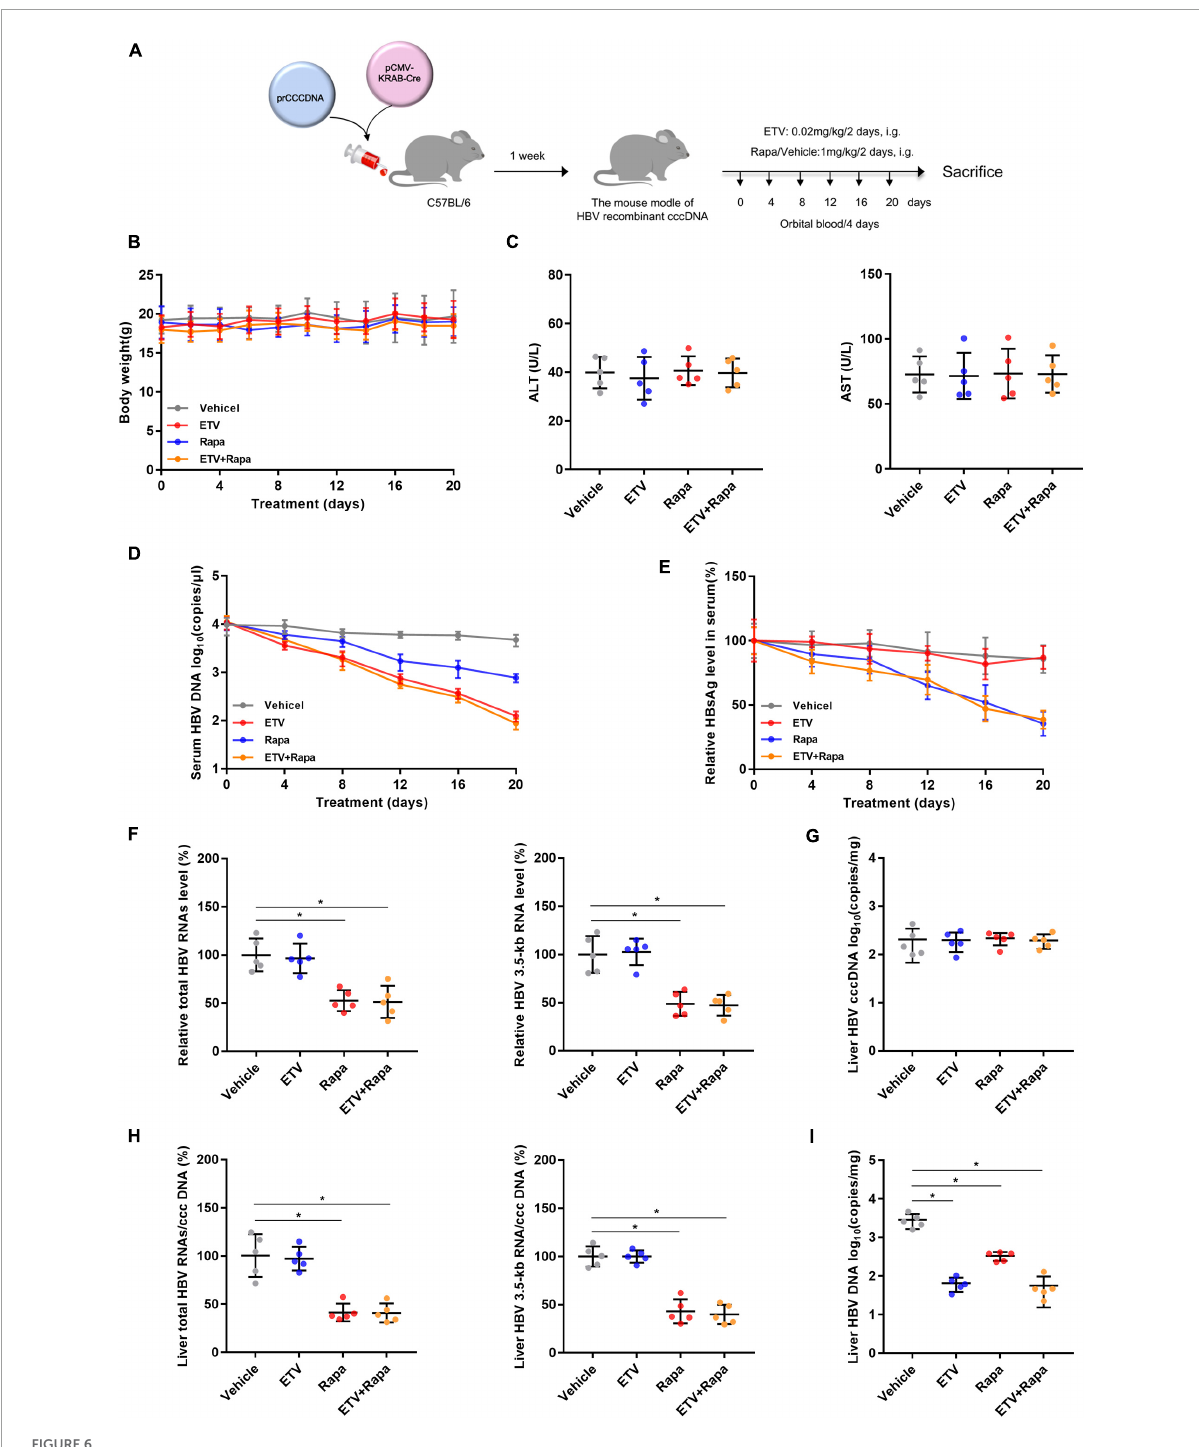
FIGURE6 Rapamycin showed effective antiviral activity against HBV in (r)cccDNA mice. (A) A flow chart explaining the method and concentration of ETV and rapamycin as well as the interval of orbital blood collection. The mouse model was established by injecting 4 µ g prcccDNA and 4 µ g pCMV-KRAB-Cre into the tail vein, and models with HBV infection involving HBV (r)cccDNA that were constructed successfully and were randomly assigned to four groups ( n = 5 per group). Blood samples were collected every 4 days for 20 days. (B) The mouse’s body weight was measured by an electronic scale. (C) ALT and AST were detected by corresponding kits using a microplate reader. (D) The level of HBV DNA in the serum was analyzed by real-time PCR. (E) HBsAg in the serum was measured by an ELISA kit. (F–H) The levels of total HBV RNAs, 3.5-kb RNA, and cccDNA were analyzed by real-time PCR, and the ratios of HBV 3.5-kb RNA/cccDNA and total RNAs/cccDNA were calculated. (I) The level of HBV DNA in the liver was analyzed by real-time PCR. The data are presented as the mean ± SD. * P <